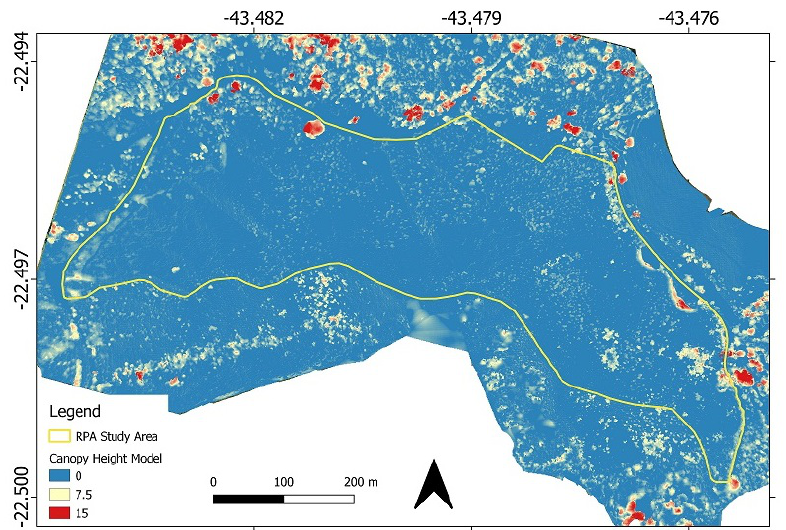
Figure 7. The Canopy Height Model (CHM) results of the RPA study area, which provided the height of the trees that were automatically identified. The zero CHM values mean grasses or non-vegetated (bare soil) areas.